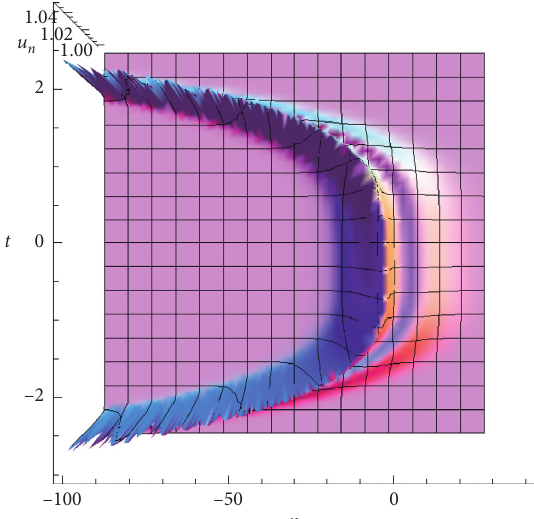
Figure 5: Spatiotemporal structure of the semidiscrete two-soliton � 1, α � 1, α � 1, α � 1, solution determined by solution (53) with the parameters α 0 1 2 3 � t , α � t 2 , α � t 3 , c ( 0 ) � 1, c ( 0 ) � 5 . 5, z α 1 2 3 1 2